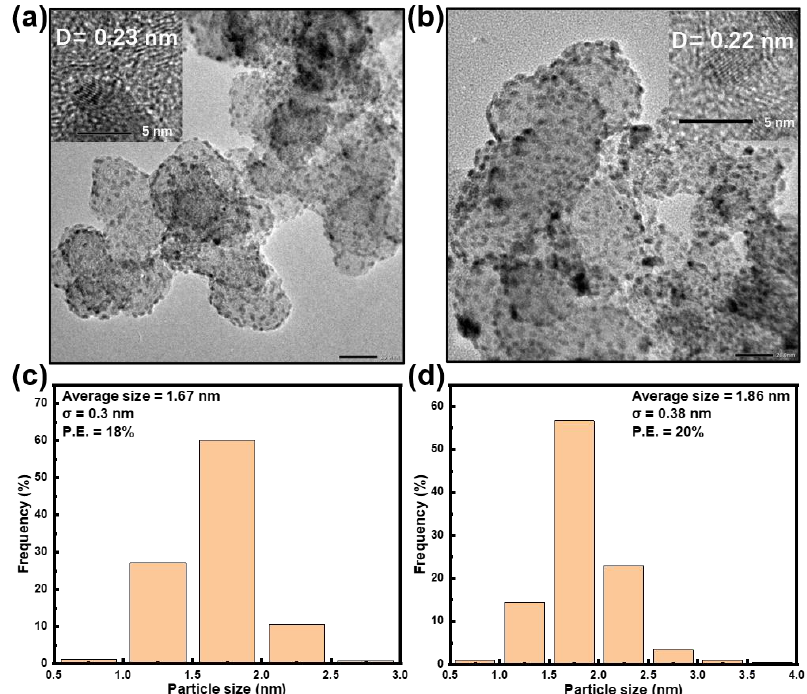
Figure 1. TEM graph for ( a ) pre-nucleation precursor and ( b ) Pd/C in situ reduction with a scale bar of 20 nm; the insert map shows the high-resolution (HR) TEM with a scale bar of 5 nm. D is the lattice spacing of the particle shown. size distribution of ( c ) pre-nucleation precursor and ( d ) Pd/C in situ reduction. the σ is the standard deviation of the particle size and the P.E. represents the percent error calculated by σ/average size.